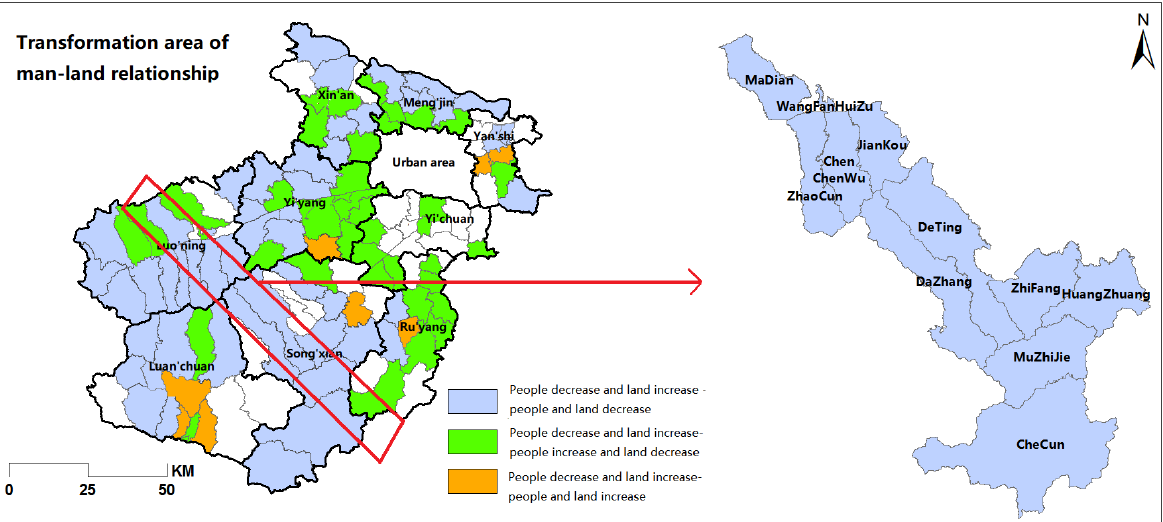
Figure 10. The location map of the typical sample area of people decrease and land increase—people and land decrease.